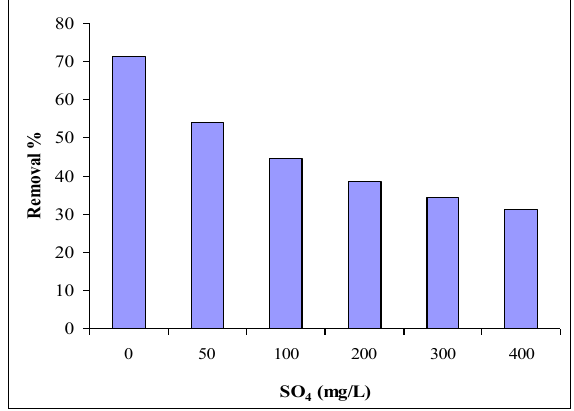
Figure 2 . Comparison of removal percentage for degradation of diazinon in the presence of